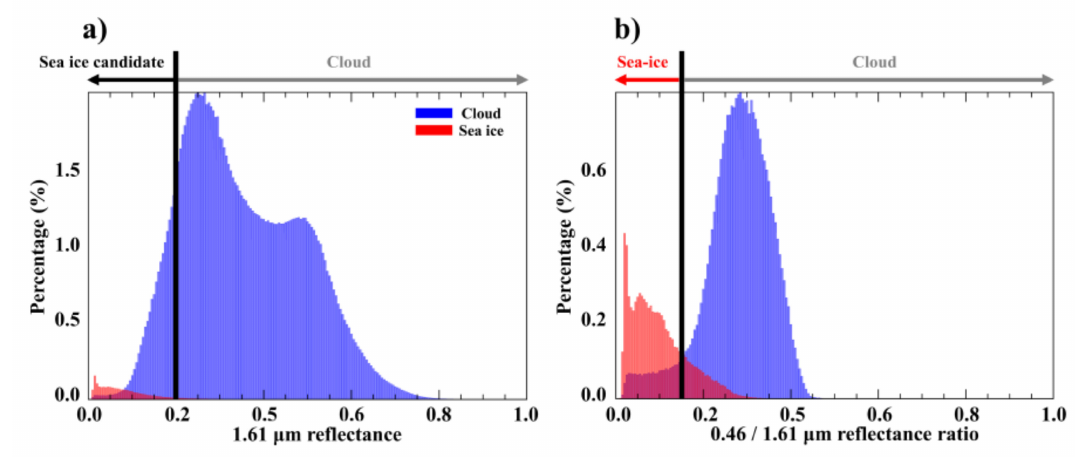
Figure 4. ( a ) distribution of R 1.61 , and when R 1.61 > 0.2, it is divided into clouds, ( b ) distribution of reflectance ratio of the sea ice candidate pixels, not classified by R 1.61 . Targeting the “low-confidence cloudy” area, distribution on Himawari-8 / AHI channel data ( R 1.61 and ratio of R 0.46 and R 1.61 ) corresponding to MOD29 sea ice and cloud pixels, which are reprojected on Himawari-8 / AHI full disk, Targeting the “low-confidence cloudy” area of the GK-2A / AMI cloud mask, it shows Himawari-8 / AHI R 1.61 and ratio of R 0.46 and R 1.61 , The cloud (blue) and sea ice (red) represent the MOD29 sea-ice data reprojected to Himawri-8 / AHI. The black lines in figure are set empirically according to the value distribution of each index ( R 1.61 and ratio of R 0.46 and R 1.61